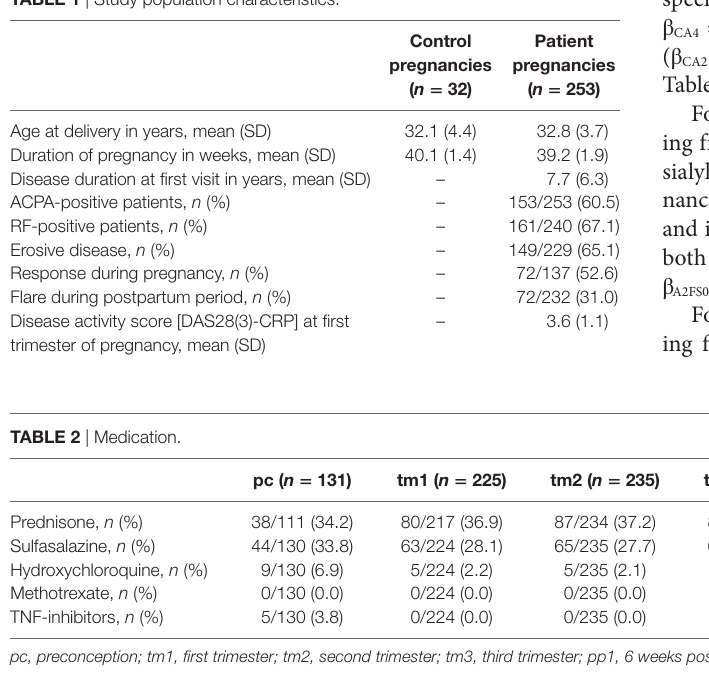
Table 1 | Study population